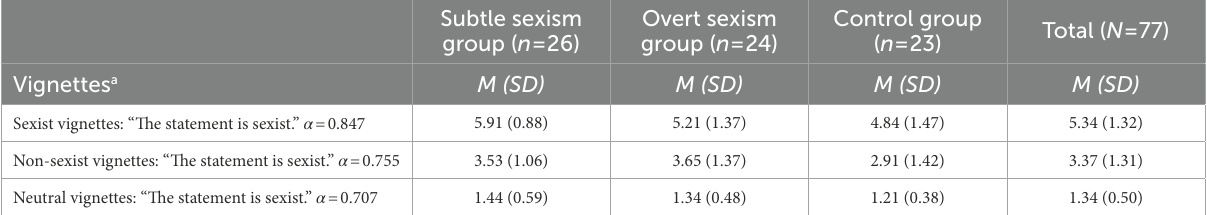
TABLE 2 Descriptive statistics of the mean ratings of the six sexist, the six non-sexist, and the six neutral vignettes across the experimental groups.